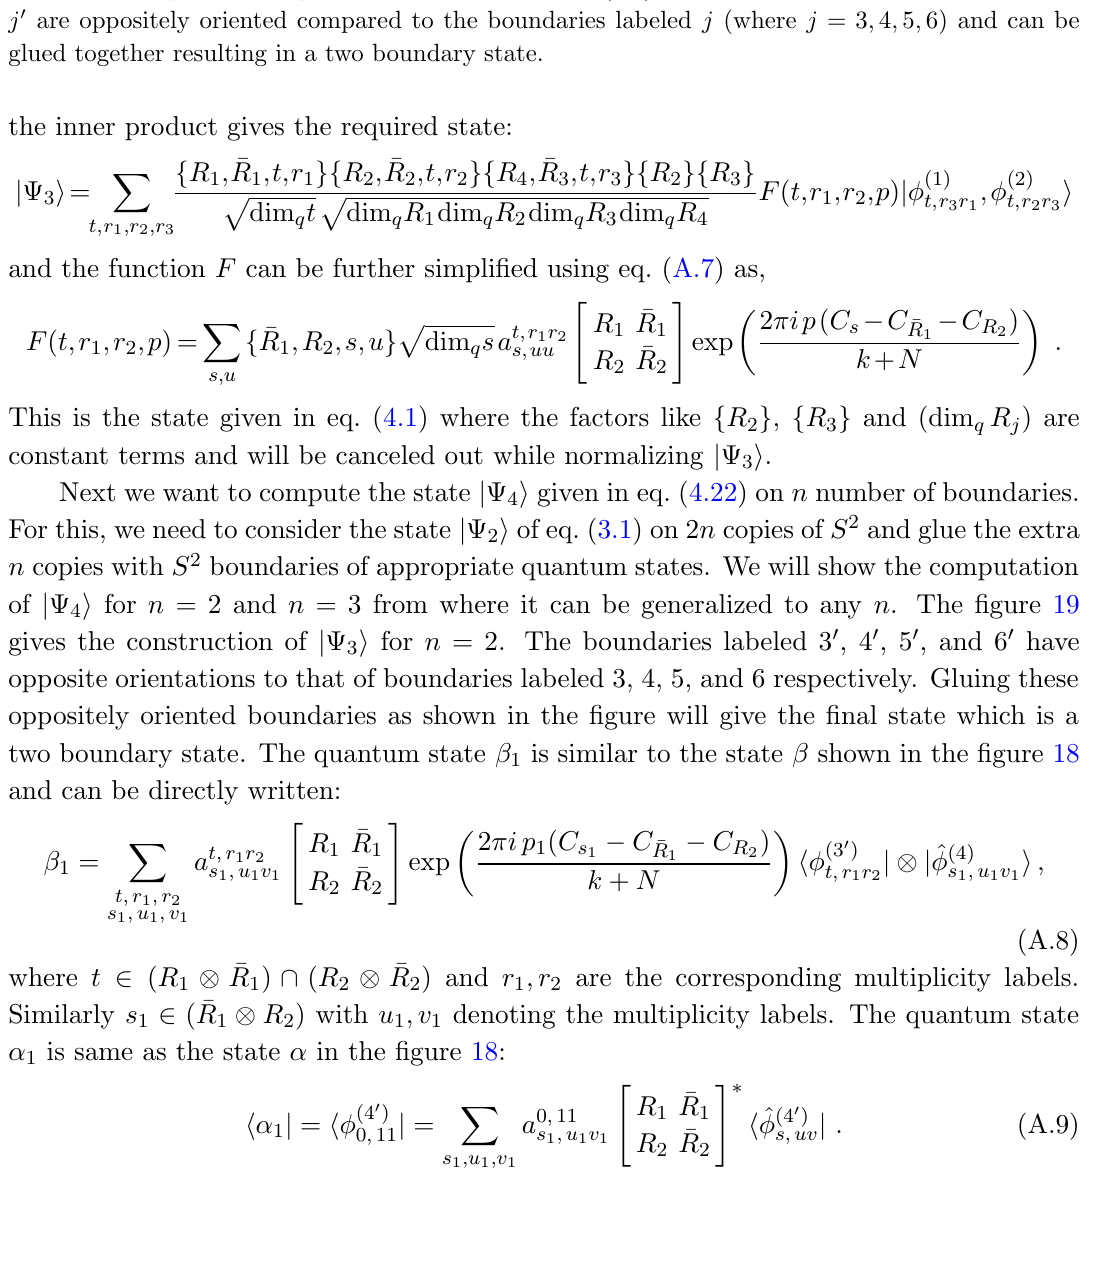
Ψ on S 2 S 2 . The S 2 boundaries labeled 4 (cid:30) | ∩